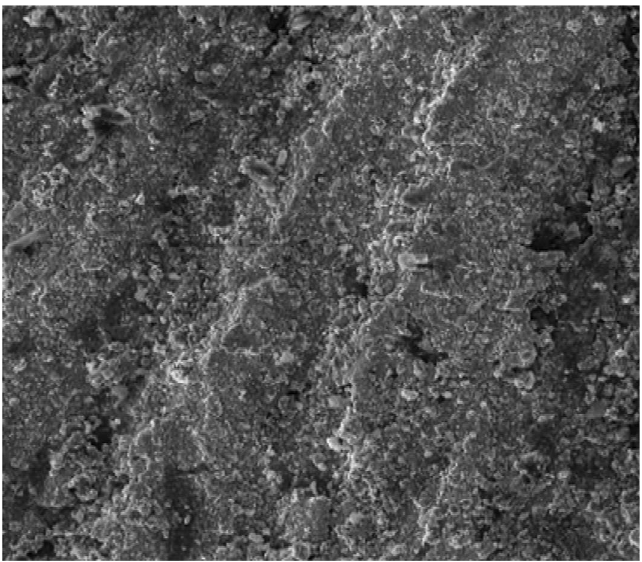
Figure 12. SEM microstructure of grey cast iron carburized at 900 °C for 150 min.